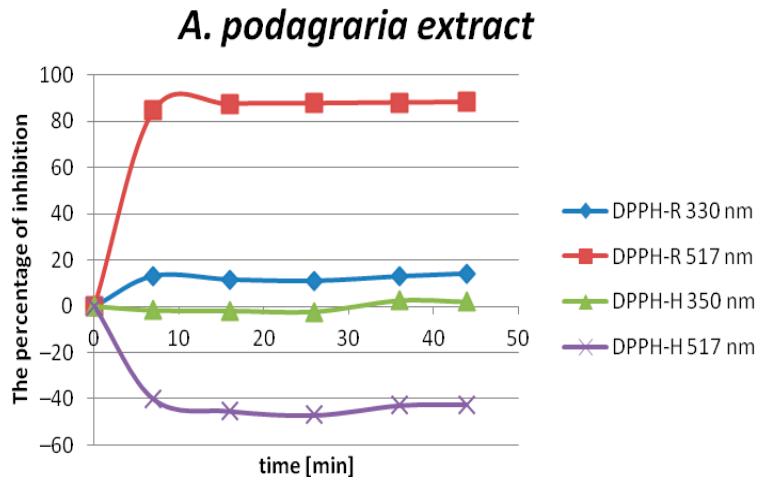
Figure 7. The inhibition percentage of the DPPH-R/DPPH-H couple by A. podagraria extracts vs. time measured at different wavelengths. Conditions: 1 mL DPPH (0.7 mM) in MeOH + 500 µL extract (I) + 500 µL MeOH.